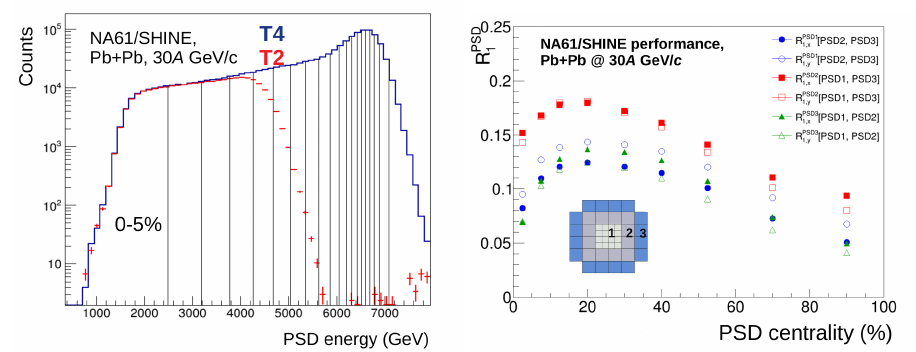
Figure 7. Left: Central and minimum bias trigger in Pb + Pb collisions at 30 A GeV / c. Right: Resolution { B , C } obtained for PSD subgroups using 3-subevent method. For details see of the correction factors R A 1